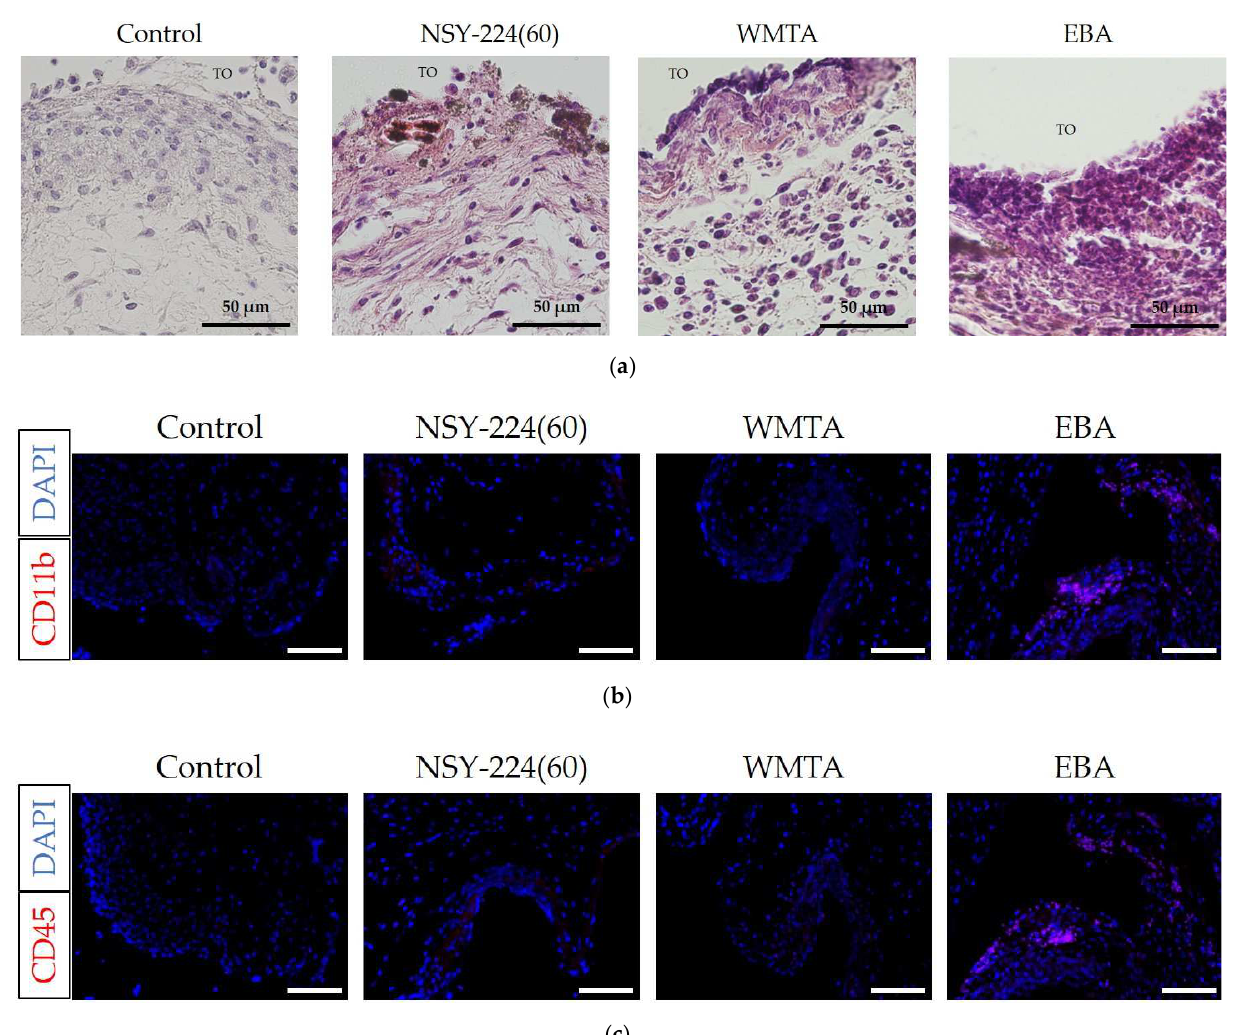
Figure 5. Effects of cements on inflammation in vivo. Histologic findings corresponding to mouse subcutaneous tissue adjacent to each cement specimen on the 7th day. Sections were stained with hematoxylin–eosin ( a ) and observed using light microscopy (×400 magnification). Scale bars, 50 µm. TO: tube opening. ( b , c ) Fluorescent images of the myeloid cell marker CD11b ( b ) and leukocyte marker CD45 ( c ). Sections were incubated with Alexa 546 fluorescent secondary antibodies and mounted with mounting media containing the nuclei stain DAPI. Red correlates with the neutrophil and monocyte marker and blue staining correlates with the DAPI. Scale bars, 100 µm (×40 magnification).